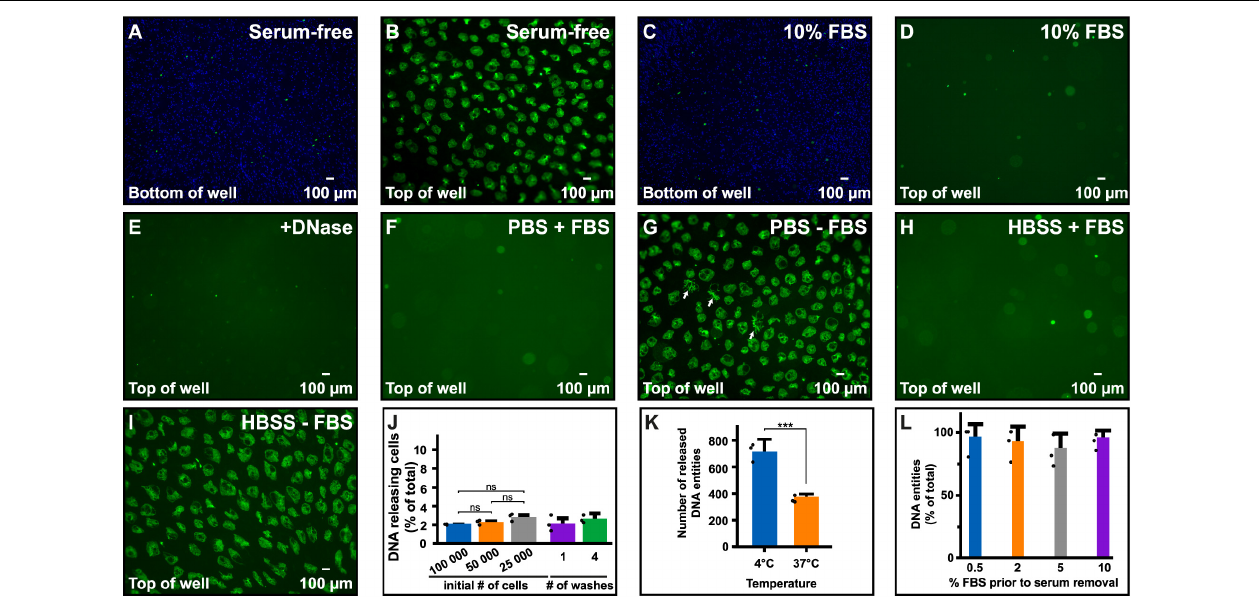
FIGURE 1 | Cells release their DNA in serum-free media. (A–D) Microscopy images using a 4 × objective directly over the plate in which Nalm-6 cells were seeded in medium with or without FBS and stained with Hoechst 33342 (blue). Following incubation for 30 min, SYTOX Green nucleic stain (green) was added to stain extracellular DNA and necrotic cells. (A) Nalm-6 cells at the bottom of the well seeded in serum-free medium. (B) Extracellular DNA in supernatants at the top of the same well as in panel (A) . (C) Nalm-6 cells in serum containing medium at the bottom of the well. (D) Extracellular DNA at the top of the same well as in panel (C) . (E) Extracellular DNA in supernatants after treatment with DNase. (F–I) Nalm-6 cells in PBS and Hanks’ balanced salt solution (HBSS) with (F,H) or without (G,I) 10% FBS using a 4x objective. Arrowheads in panel (G) highlight irregular shaped DNA. (J) Number of Nalm-6 cells, expressed as percentage of total, releasing DNA extracellularly when seeded in serum-free medium. Cells were seeded in 150 µ l to study the impact of cell density and washing on the release. All released DNA entities were counted and related to the total number of cells in the experiment. N = 3. (K) Release of DNA from Nalm-6 cells incubated for 30 min in PBS at two different temperatures. Data shows the mean of three independent experiments and represents the number of DNA entities observed in three individual images recorded from different positions in each sample. (L) Quantification of DNA release after acclimatizing cells to different concentrations of FBS for 16 h prior to serum removal. No significant differences were observed. Statistical analyses were done using unpaired t -test (K) , *** P < 0.001, or one-way ANOVA followed by Turkey’s multiple comparisons test (J,L) . Filled circles in panels (J–L) represent the mean in each individual experiment.